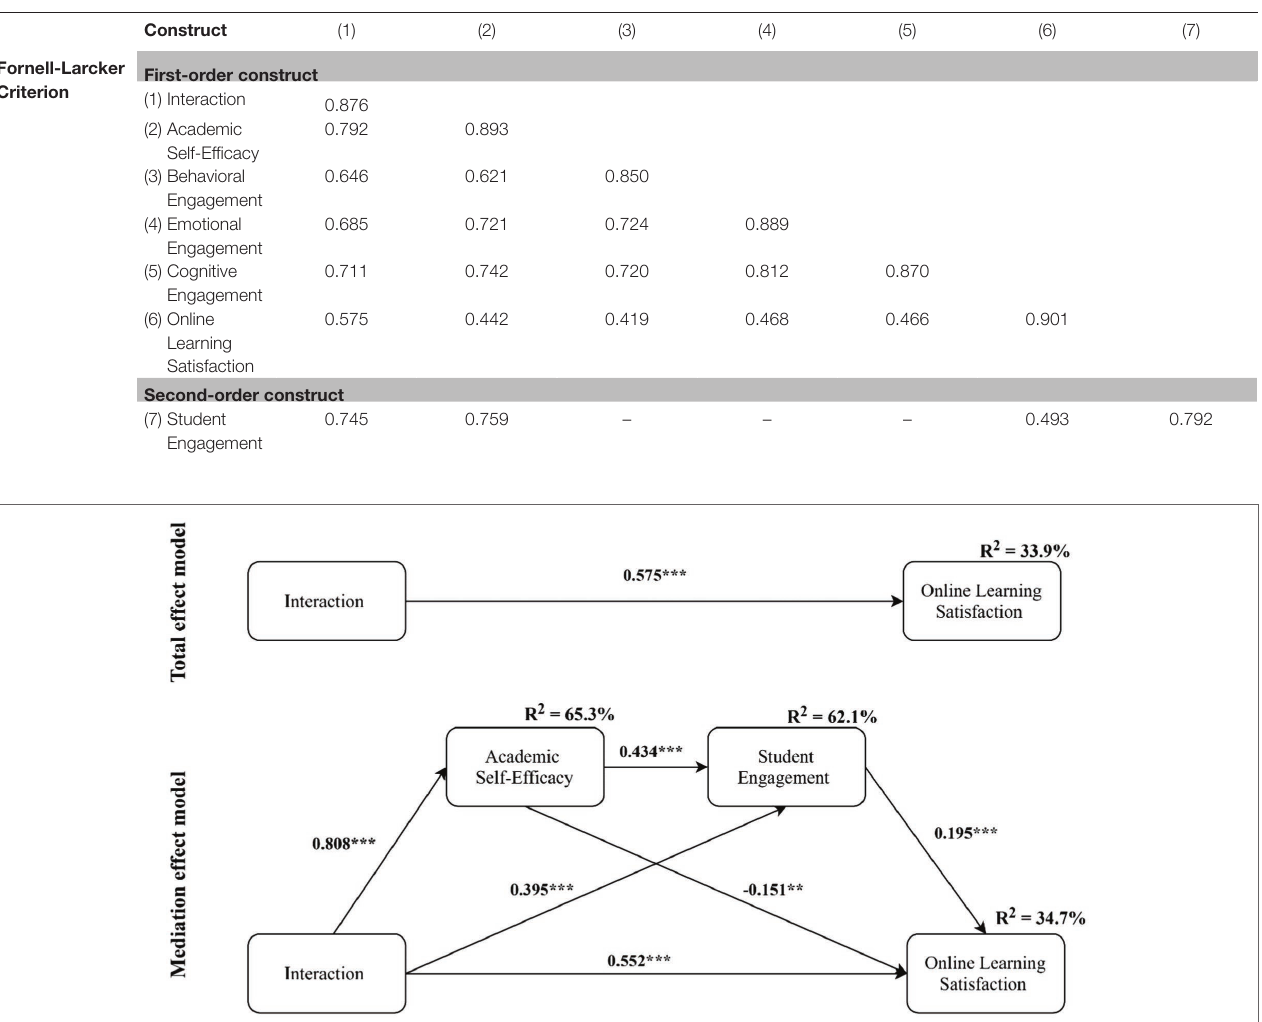
TABLE 2 | Discriminant validity assessment using the Fornell-Larcker criterion. Construct